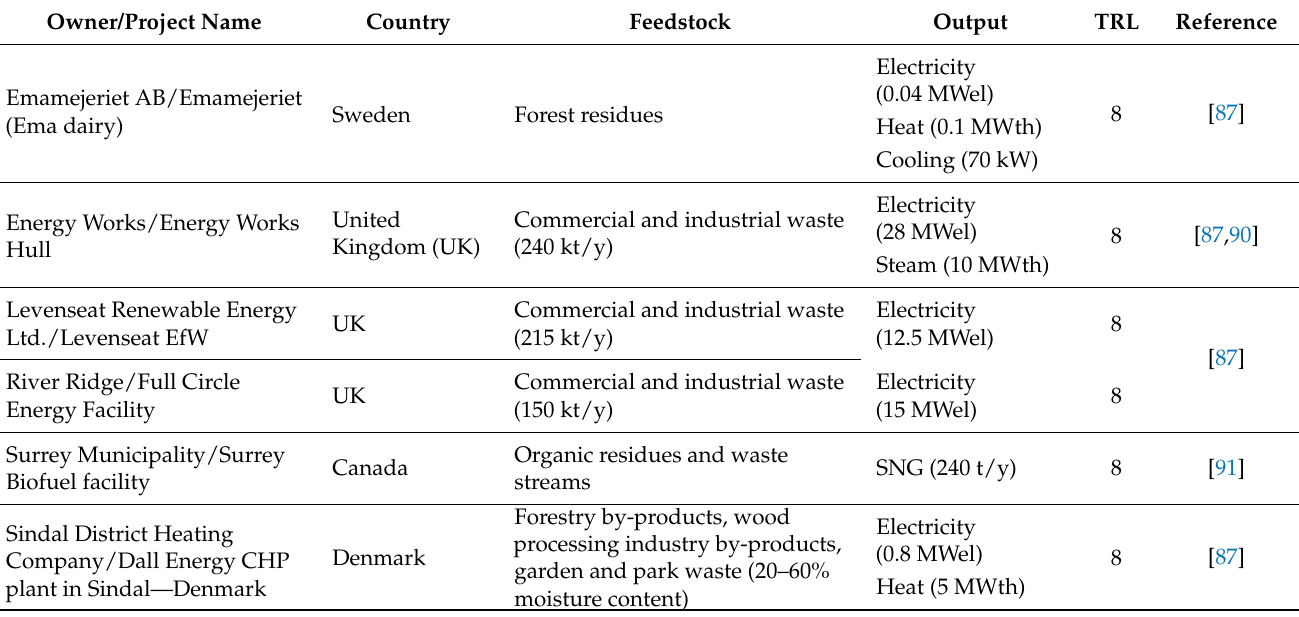
Table 5. Operational waste gasification plants (commercial